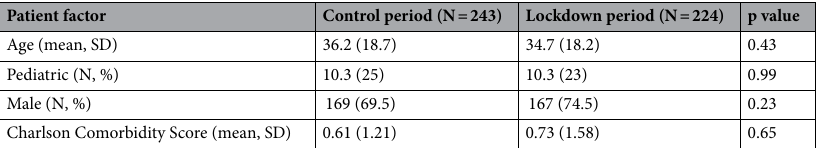
Table 1. Patient characteristics of trauma activations during the control and lockdown period. SD standard deviation. *Pediatric age was considered any patient under 17 years